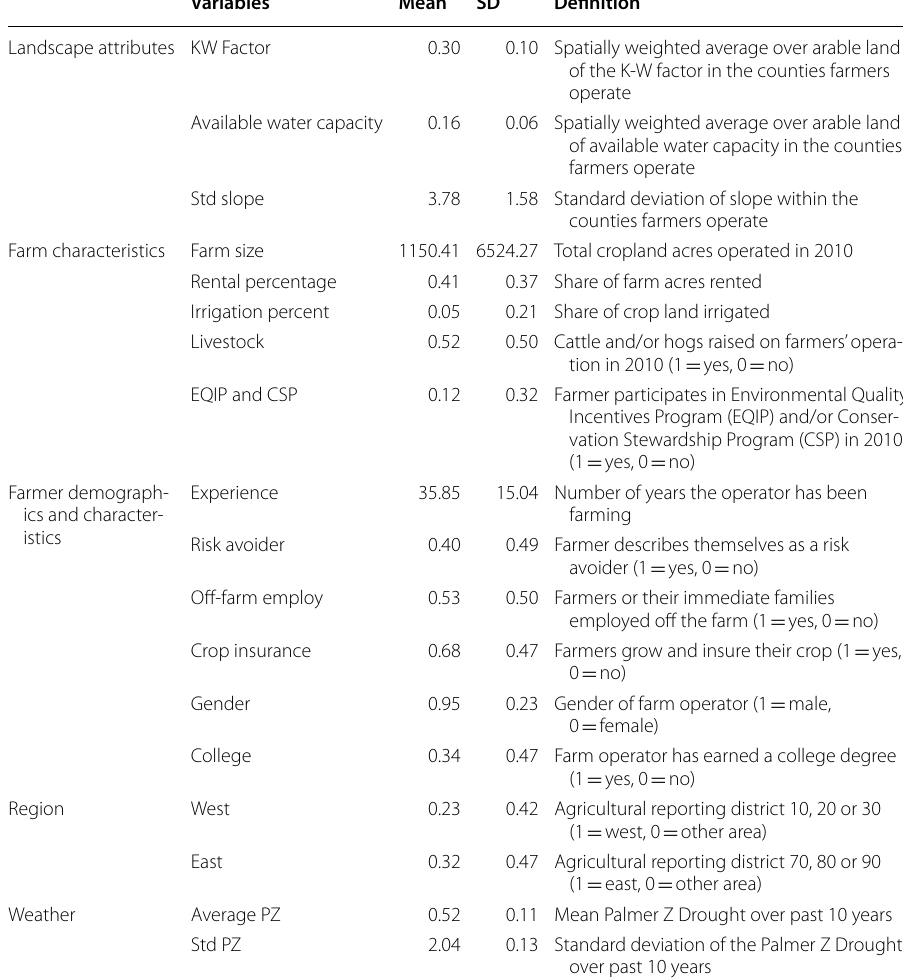
Table 1 Definition of Explanatory Variables and Summary Statistics ( n